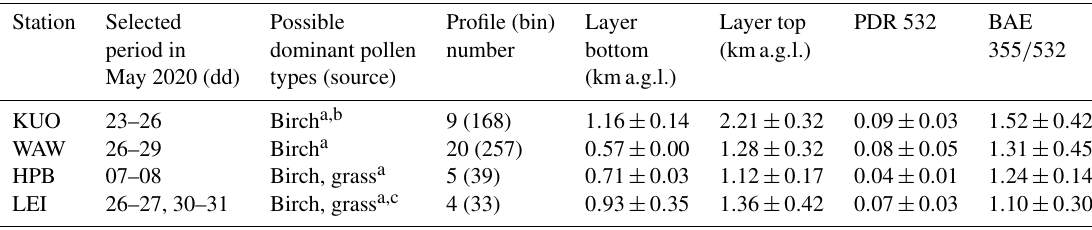
LEI 26–27, 30–31 Birch, grass a,c